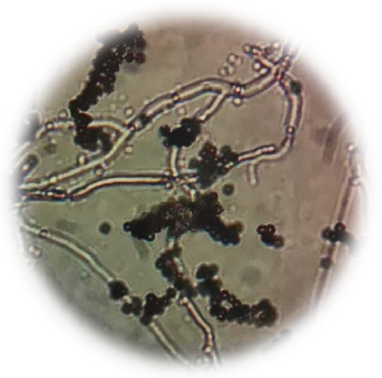
Figure 3. Morphology of Aspergillus sp. detected from Krajood strips.